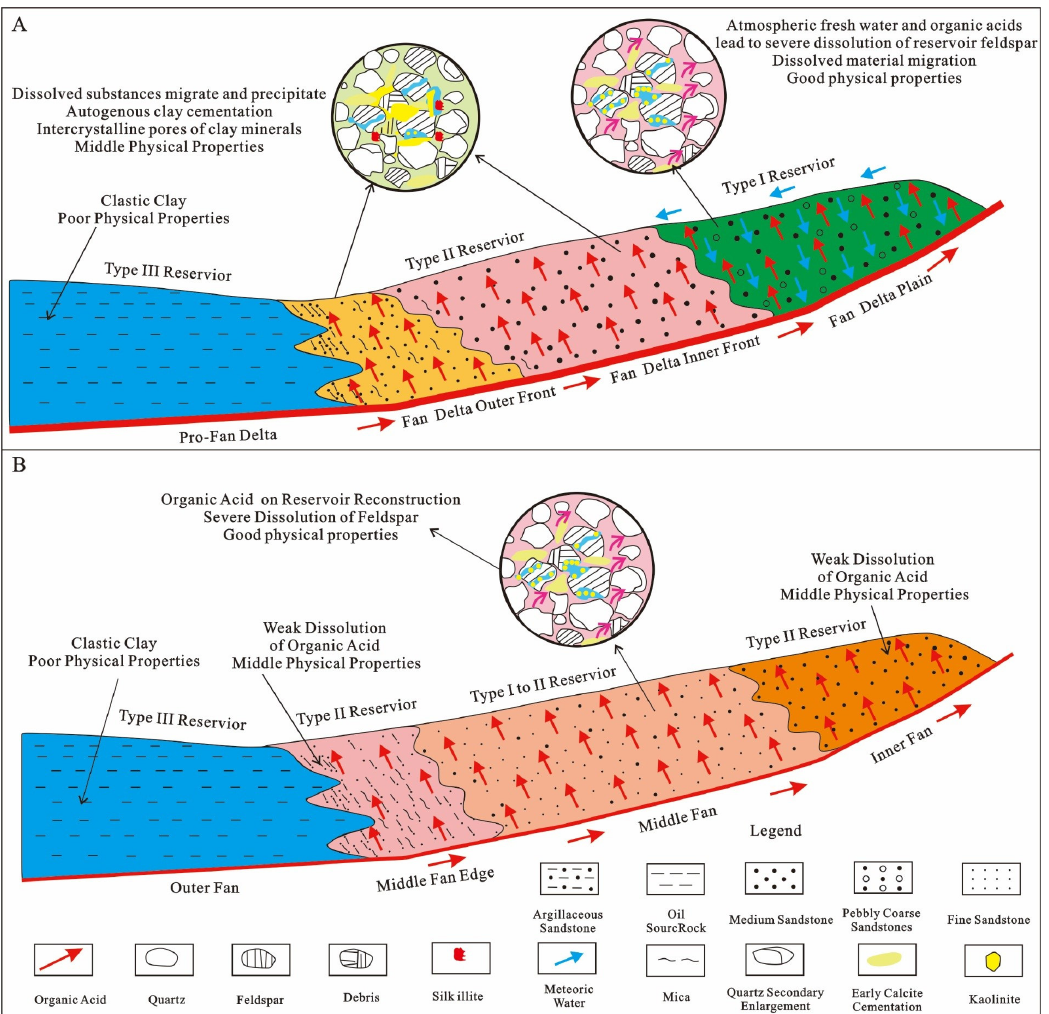
Figure 14. Reservoir prediction model of the ( A ) fan delta and ( B ) nearshore subaqueous fan in the Weixinan Sag.